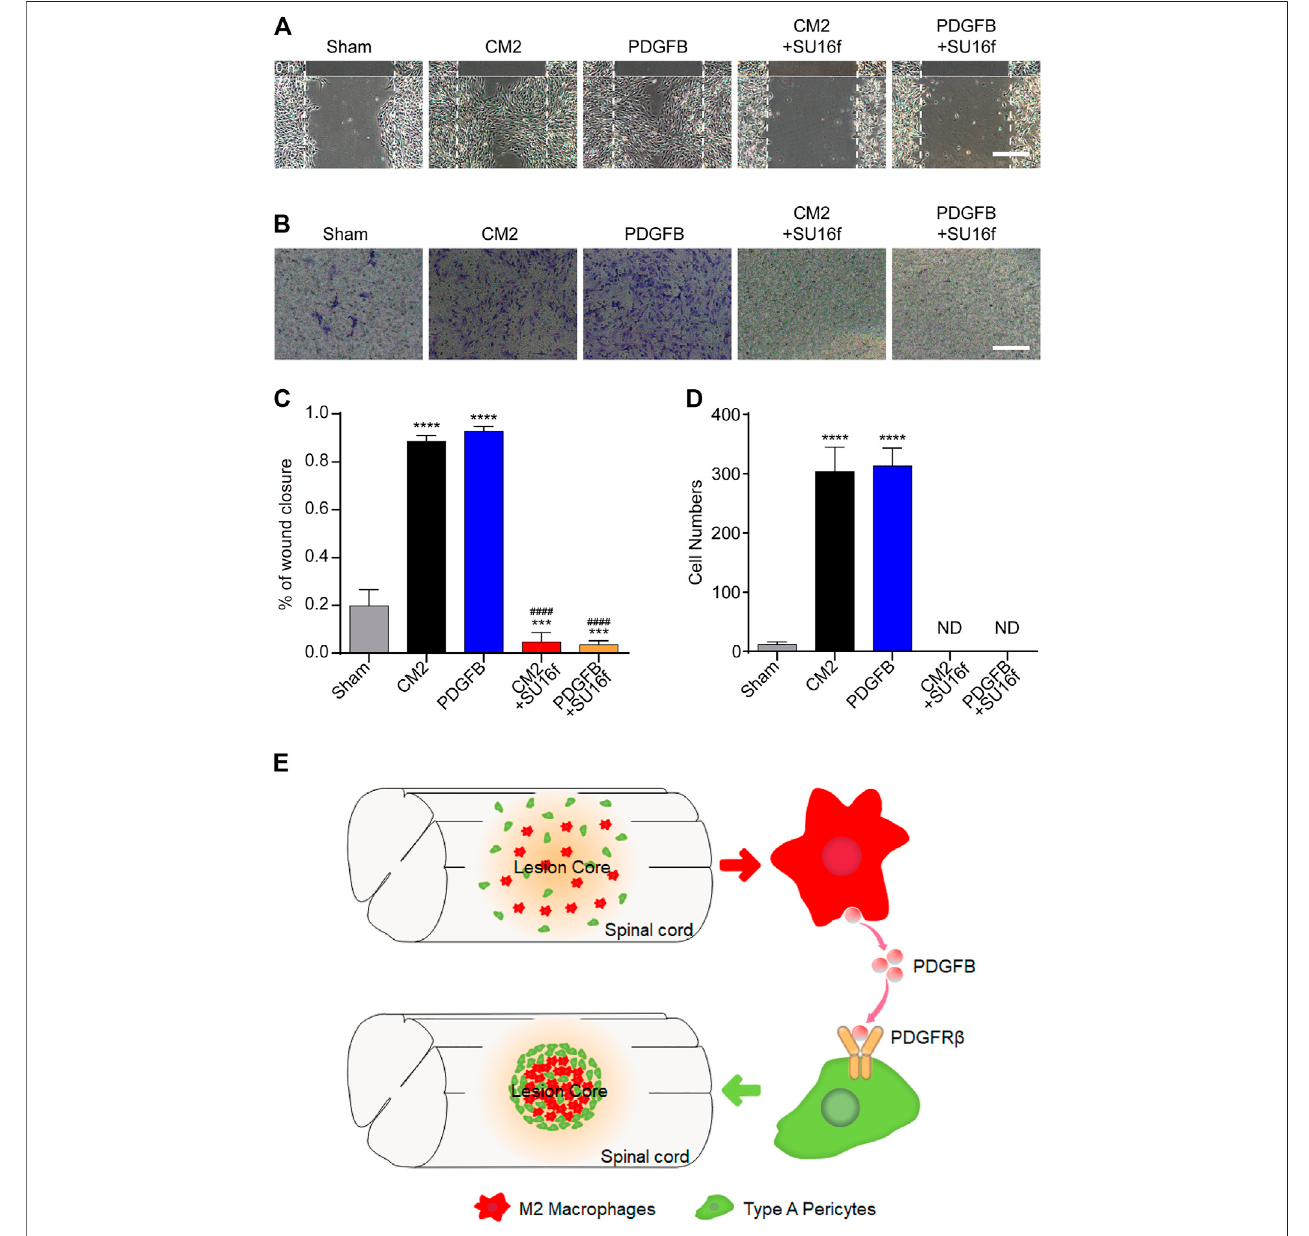
FIGURE 7 | M2 macrophages secrete PDGFB acting on PDGFR β to promote PDGFR β + pericytes migration in vitro . (A) Scratch test was used to detect the migration of PDGFR β + pericytes after being treated with DMEM (Sham),conditioned medium ofM2 macrophages (CM2), 10 ng/ml recombinant mouse PDGFB protein (PDGFB), CM2 plus 10 μ m PDGFR β inhibitor (CM2+SU16f) or PDGFB plus 10 μ M PDGFR β inhibitor (PDGFB+SU16f) for 72 h ( n (cid:2) 3 per group). (B) Transwell test was used to further detect the migration of PDGFR β + pericytes after being treated in Sham, CM2, PDGFB, CM2 + SU16f or PDGFB+SU16f groups for 20 h ( n (cid:2) 3 per group). (C) Quantitative analysis of the wound closure rate in (A) , the results were quanti fi ed as previously described, **** p < 0.0001, *** p < 0.001 (groups vs. Sham), #### p < 0.0001(groupsvs. CM2andPDGFB). (D) Quantitative analysisofthenumber oftransmembrane cellsin (B) ,theresults werequanti fi edaspreviouslydescribed, **** p < 0.0001 (CM2 and PDGFB vs. other groups). ND, not determined. Scale bars, 100 μ m. (E) Schematic representation. M2 macrophages could secrete PDGFB, acting on PDGFR β of PDGFR β + pericytes, which promote the formation of fi brotic scar, corral macrophages and limit in fl ammation after